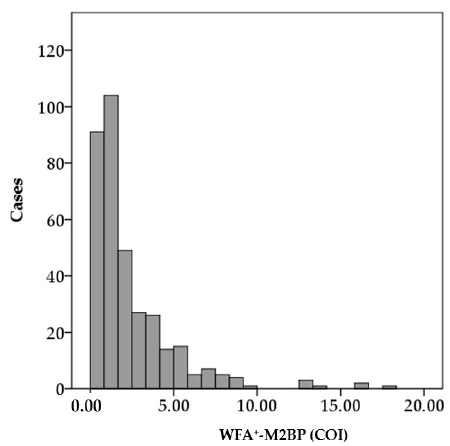
Figure 1. Distribution of serum Wisteria floribunda agglutinin-positive Mac-2-binding protein (WFA + -M2BP) levels in the study cohort. COI, cut off index.